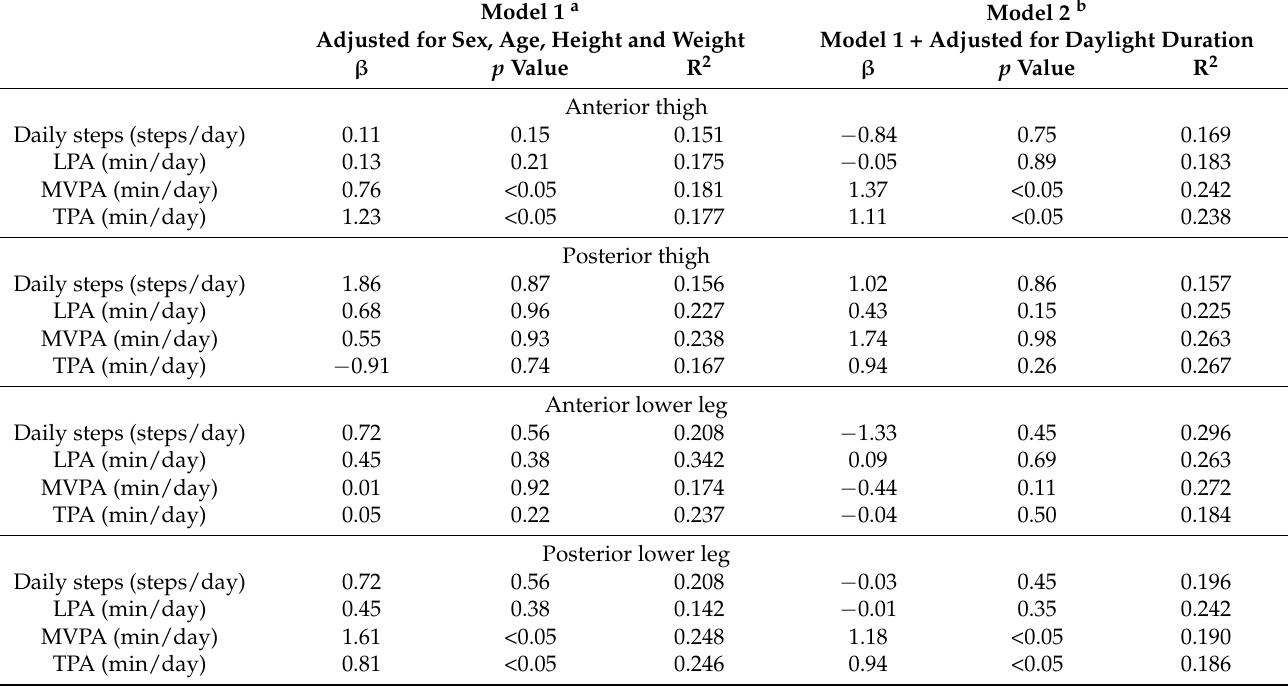
Table 2. Multivariate linear regression investigating the association of accelerometer-based PA data with muscle